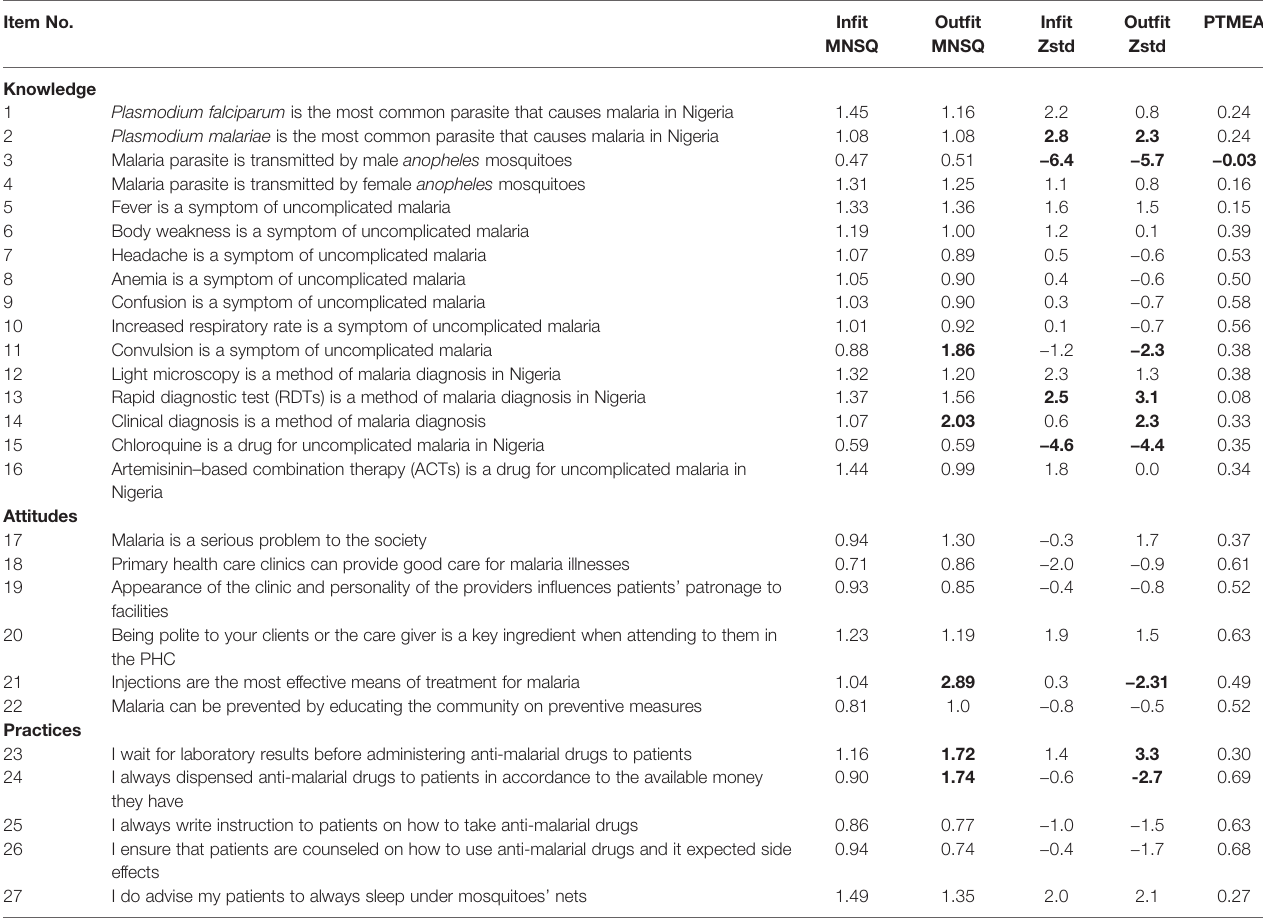
TABLE 3 | Items fi t and mis fi t indices for draft healthcare workers ’ knowledge, attitudes, and practices instrument for uncomplicated malaria containing 27 items (N = 121). Item No.